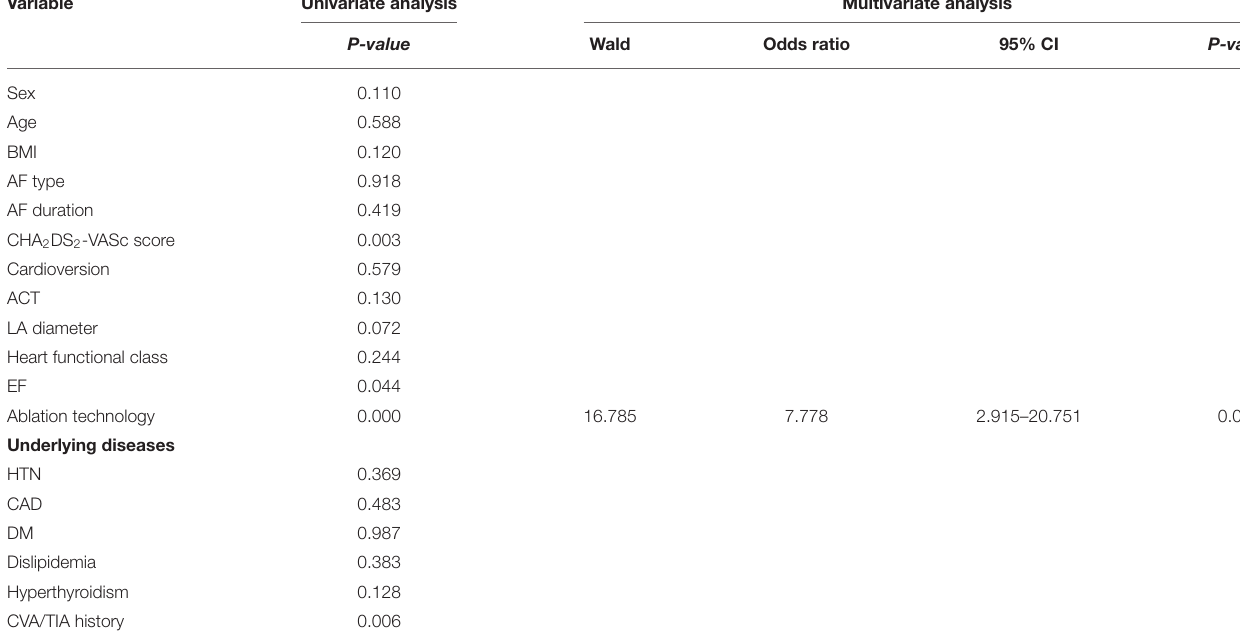
TABLE 4 | Risk factors of silent cerebral embolism after pulmonary vein isolation in atrial fibrillation ablation.